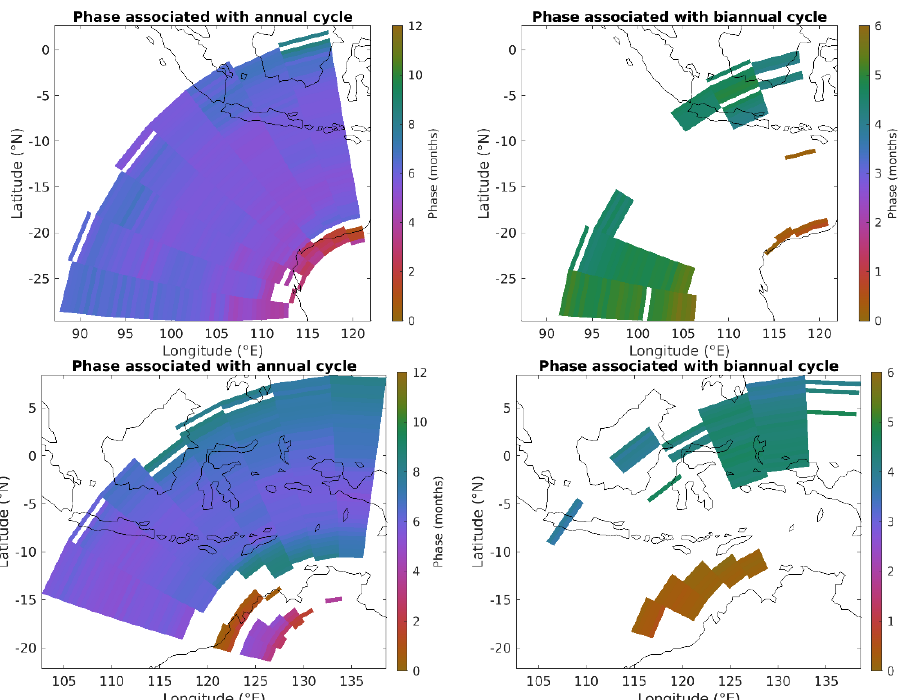
Figure 16. Phase from the Fourier analysis on the LO, LAE, LAW and AS backscatter coefficients (listed from top to bottom). ( Left ): The phase associated with the annual cycle. ( Right ): The phase associated with the biannual cycle. Phases of 0 and 12 months correspond to January. Only locations where a significant peak occurred at the specified frequency are shown.